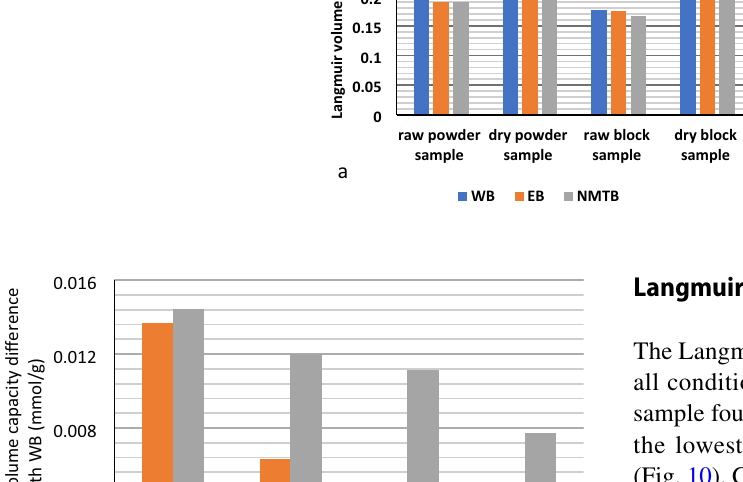
Fig. 10 Langmuir param- eters for CO 2 adsorption of all measured samples: a Langmuir volume capacity and b Lang- muir pressure